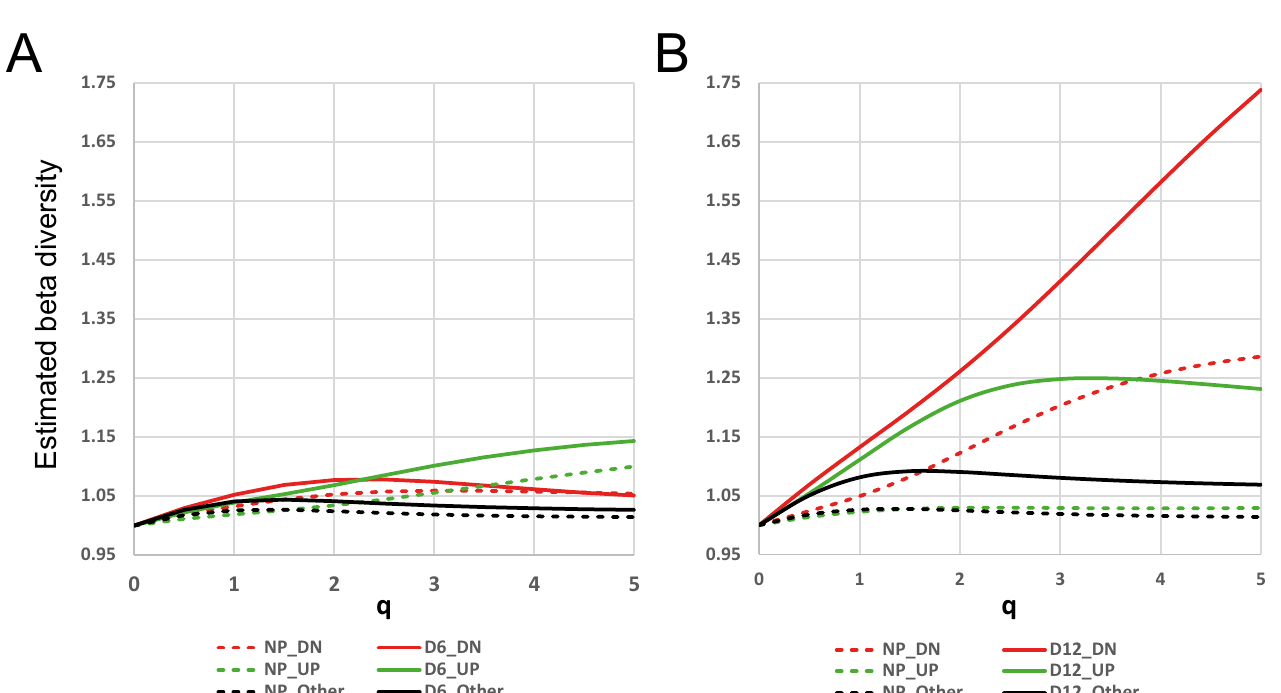
Fig 4. Beta diversity analysis. For each UP (red), DN (green), and Other (black) subsets (see S2 Fig and Material and Methods section), the beta diversity was calculated across profiles belonging to NP (dashed line), and D6 ( A ) or D12 ( B ) samples (plain line), respectively, with the DivEst function as a function of q comprised between 0 and 5 with a step of 0.5. A value of 1 means that profiles at this time-point are similar in terms of diversity, thus equivalent to their average.